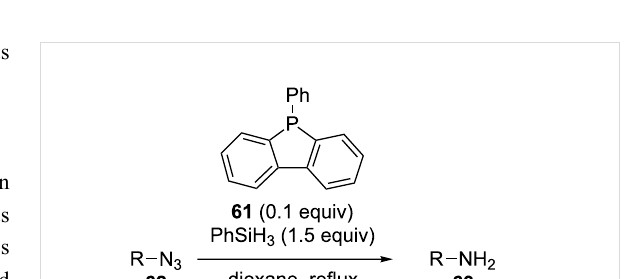
Scheme 16: Catalytic aza-Wittig reactions in benzimidazole synthesis.